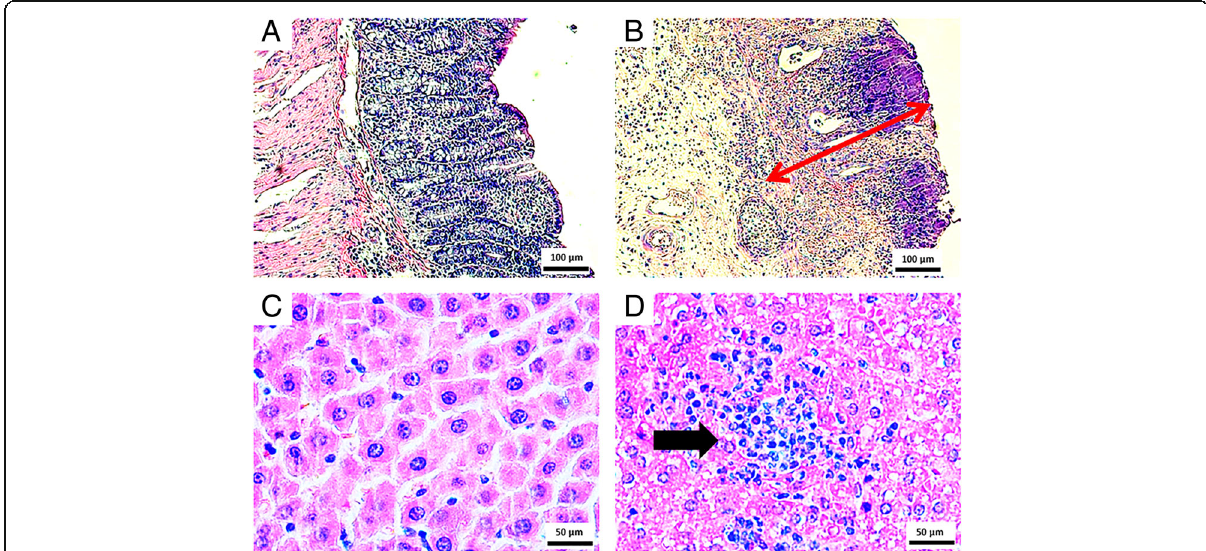
Fig. 1 Images of hematoxylin and eosin staining of acetic acid-induced UC and alcohol-induced steatohepatitis control groups. a Negative control of UC Model (× 100; scale bar = 100 μ m). b Acetic acid-induced UC. The red arrow indicates leukocyte infiltration of the mucosa area (× 100; scale bar = 100 μ m). c Negative control of steatohepatitis (× 200; scale bar = 50 μ m). d Alcohol-induced steatohepatitis. The black arrow indicates leukocyte infiltration (× 200; scale bar = 50 μ